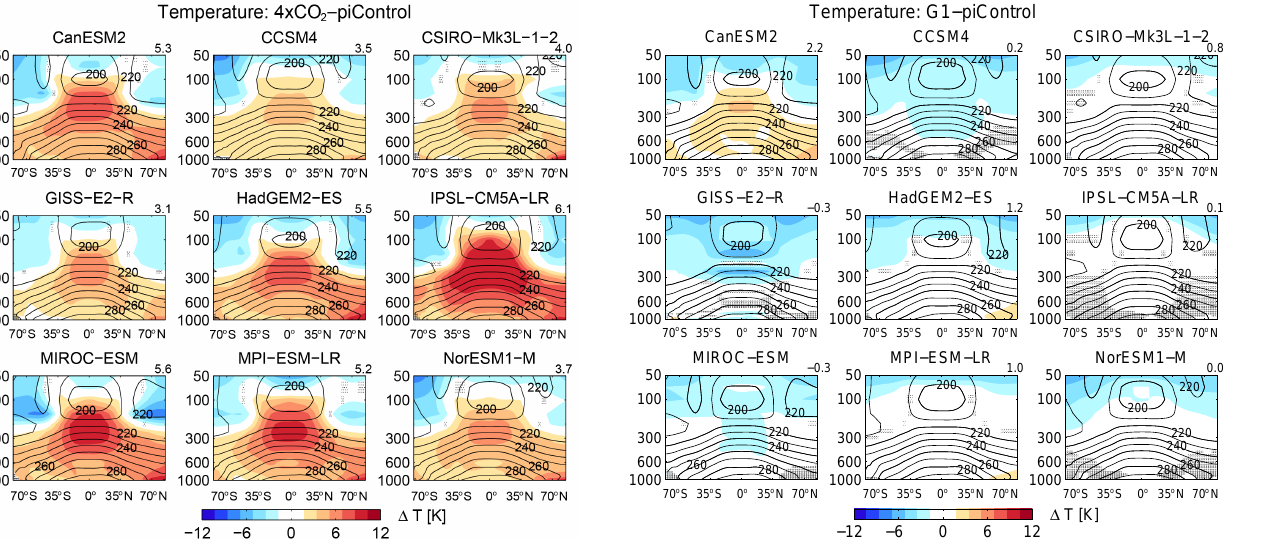
Figure 2. The difference in the zonal-mean temperature between the 4 × CO 2 and piControl experiments for each of the nine mod- els. The 4 × CO 2 experiment temperature minus the piControl ex- periment temperature is shown in shading (Kelvin), while the pi- Control experiment temperature is shown by the black contours (Kelvin). Stippling indicates differences not significant at the 95% confidence level. The change in global-mean surface temperature (Kelvin) between the 4 × CO 2 and piControl experiments is shown in the upper right of each panel.